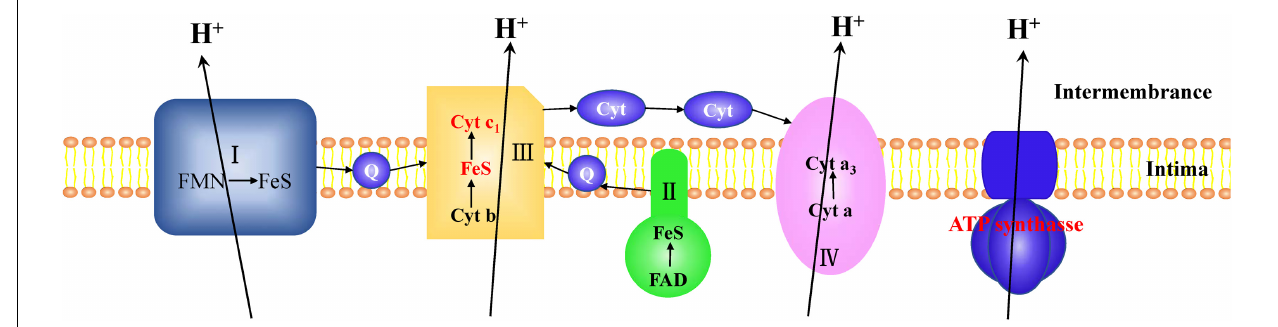
FIGURE 5 | Model for the coupling of electron transport and ATP synthesis. The differentially expressed proteins (marked in red) in the electron transport chain complex III, including ubiquinol-cytochrome c reductase cytochrome c1 subunit (E3JWK6) and ubiquinol-cytochrome c reductase iron-sulfur subunit (E3L519), were up-regulated in CYR32-5 vs. CYR32. The β subunit (F4S0Z3) of ATP synthase marked in red was up-regulated in CYR32-5 vs. CYR32.